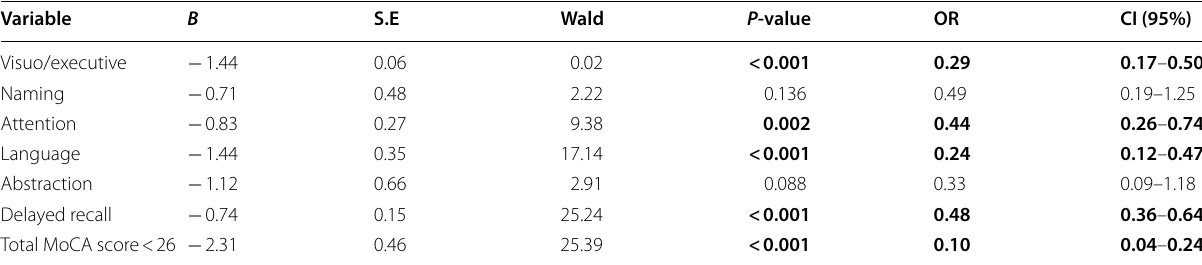
Bold text indicates statistical significance, where P -value < 0.05 Table 2 Adjusted conditional logistic regression of COVID-19 survivors and control subjects by cognitive functions